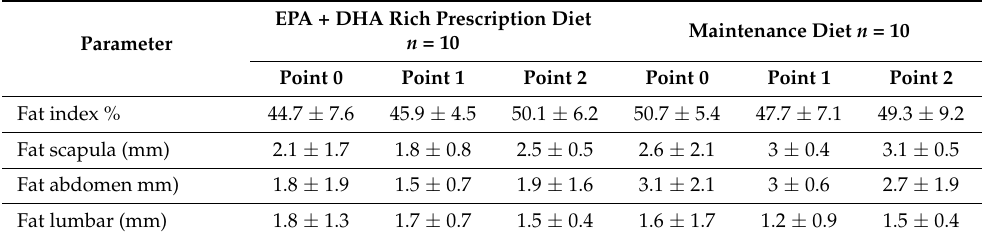
Table 5. Morphometric and ultrasonographic measurements of subcutaneous fat thickness at particu- lar time points. Average ± standard deviation.